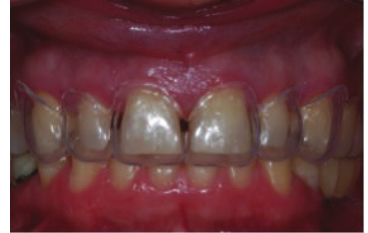
Figure 5: Surgical guide installed in the mouth.